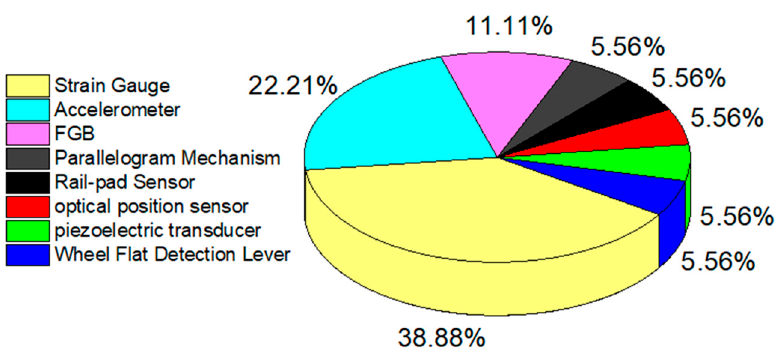
Figure 11. Usage statistics for di ff erent sensors.